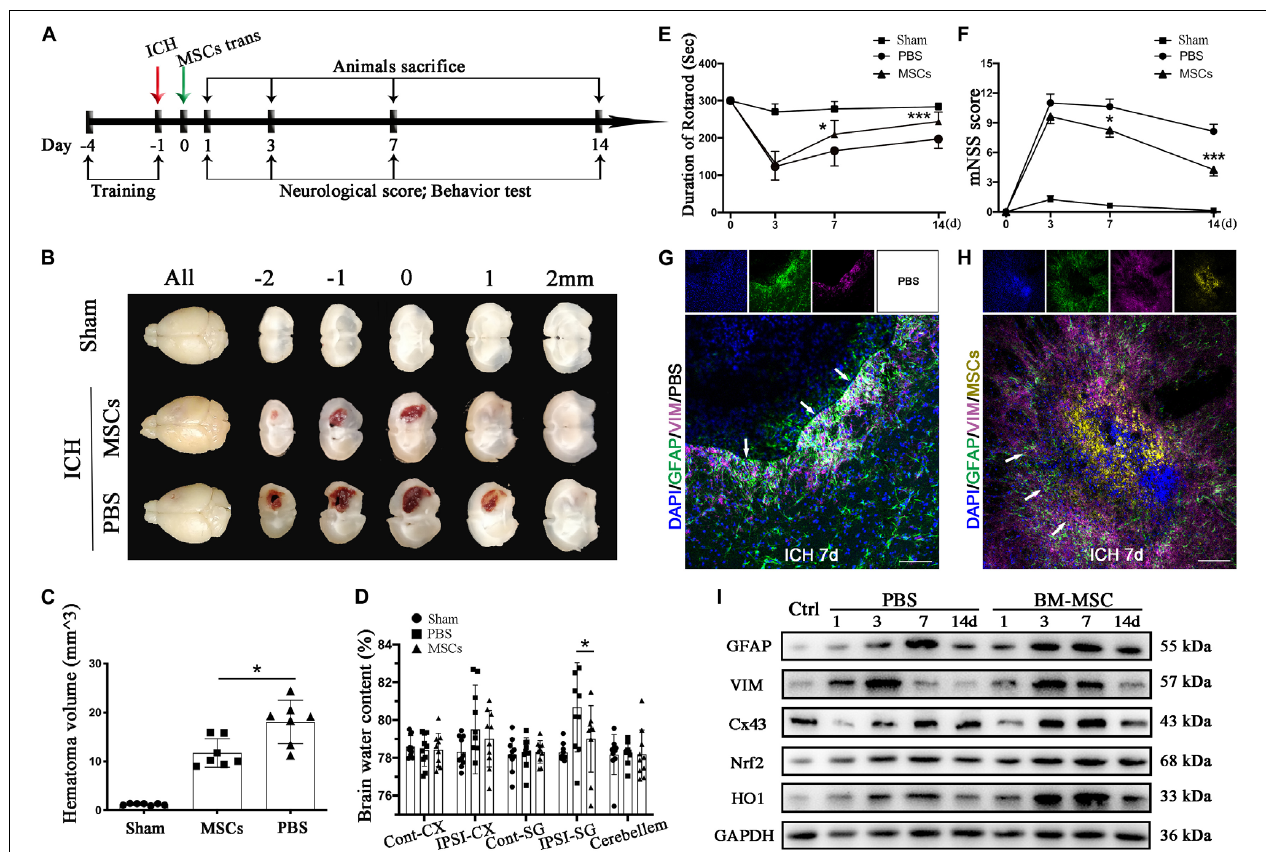
FIGURE 2 | BM-MSCs transplantation attenuated brain water content, reduced hematoma volume, improved neurological outcomes, and promoted astroglial mesenchymal phenotype switching of astrocytes after ICH. (A) Diagram in vivo experiments. (B) Coronal sections of brain tissues after 3 days post-transplantation. (C) The volume of ICH in BM-MSCs and PBS treated Mice after 3 days post-transplantation ( n = 7). (D) Brain water content at 3 days post-transplantation ( n = 10). (E,F) BM-MSCs improved neurological outcomes both in the rotarod test and mNSS ( n = 10). All data are displayed as means ± SD. The difference between groups was analyzed using One-way ANOVA test. * p < 0.05, ** p < 0.01, *** p < 0.001. (G) Immunofluorescence staining for VIM (purple) and GFAP (green) in ICH mouse brain at 7 days post-PBS transplantation. Bar = 100 µ m. GFAP was strongly expressed in reactive astrocytes, and VIM was observed around the lesion area 7 days after ICH. Glial scar (white arrows) could be seen around the hematoma. (H) Immunofluorescence staining for VIM (purple) and GFAP (green) in ICH mouse brain at 7 days with BM-MSCs (yellow) transplantation. Bar = 100 µ m. After the transplantation of BM-MSCs, VIM maintained high expression, whereas GFAP was kept at a relative low level. (I) Western blotting analysis of Cx43, GFAP, VIM, Nrf2 and HO-1 expression in ICH mouse brain of control, PBS, and BM-MSCs treatment at 1, 3, 7, and 14 days. The results of densitometric analysis of the bands were shown in Supplementary S1 .